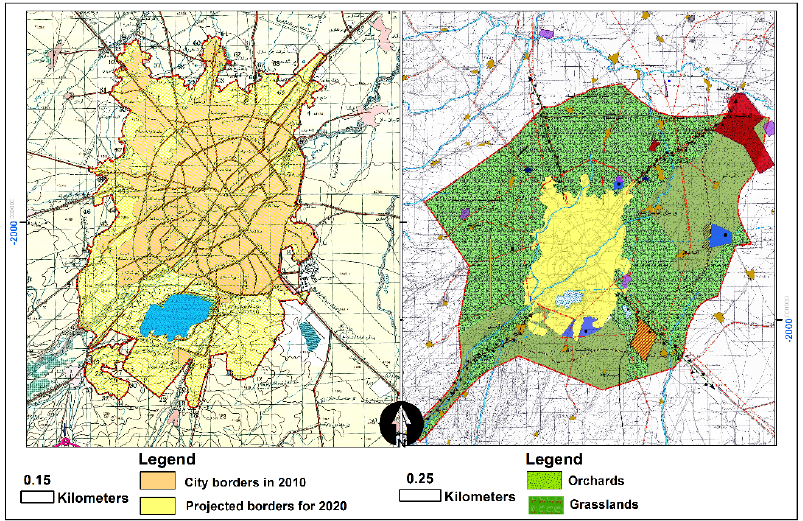
Figure 10. City area in the revised 2010 master plan and the projected area for